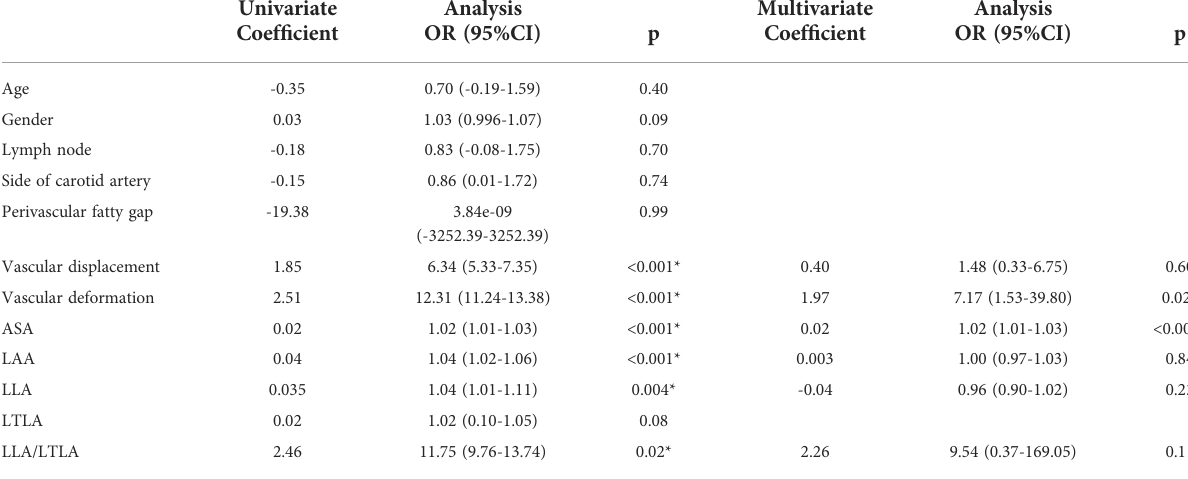
TABLE 2 Important imaging fi ndings for prediction of carotid artery